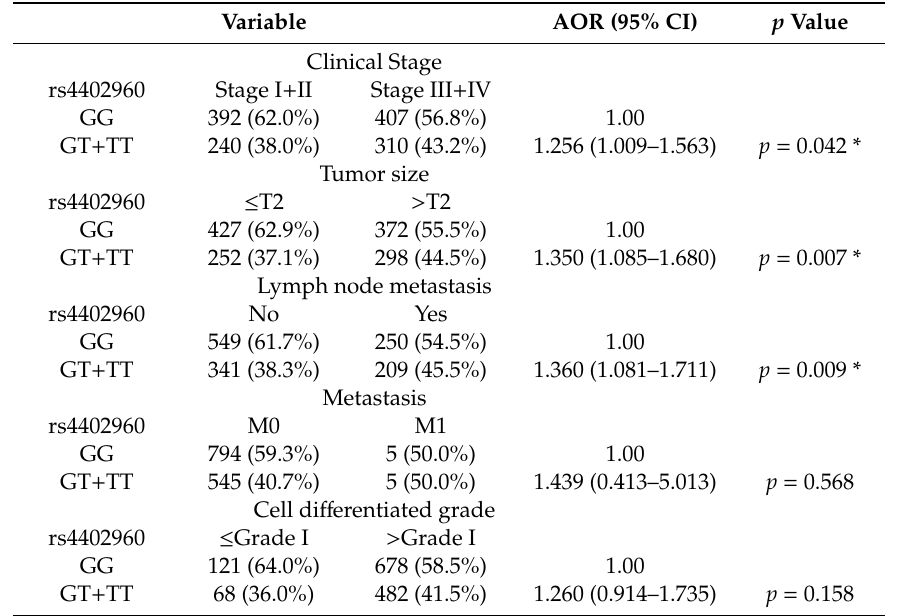
Table 4. Odds ratios and 95% CIs of clinical status associated with genotypic frequencies of IGF2BP2 rs4402960 in male patients with oral cancer ( n = 1349).